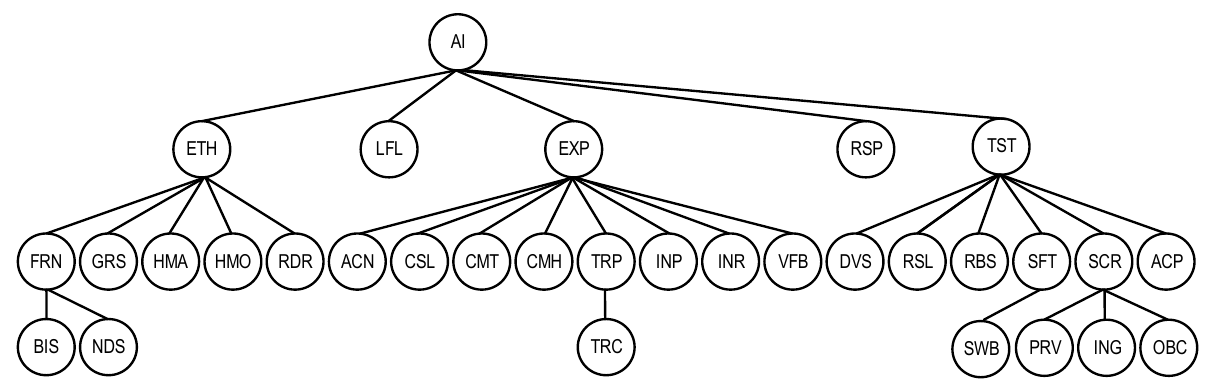
Figure 4. The graph representation of the AI quality model 𝑄𝑆 𝐶ℎ𝐴𝐼 .